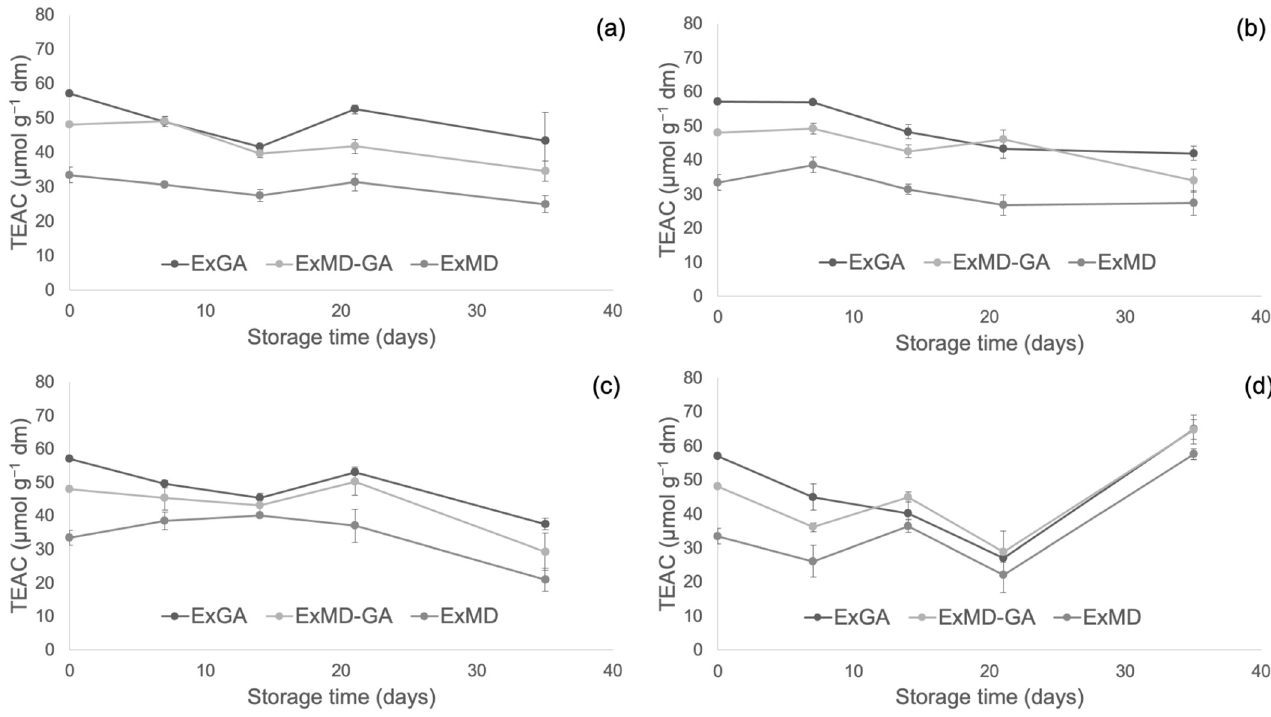
Figure 6. Trolox equivalent antioxidant capacity (TEAC) of encapsulated hop extract during storage at different temperatures: 5 °C ( a ), 20 °C ( b ), 35 °C ( c ), 50 °C ( d ).